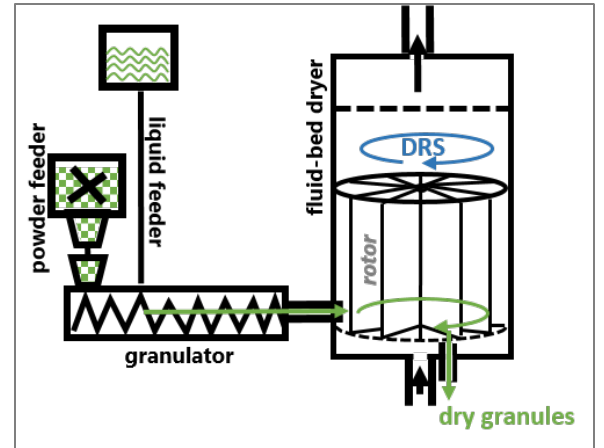
Figure 1. Overview of the investigated continuous manufacturing (CM) line.